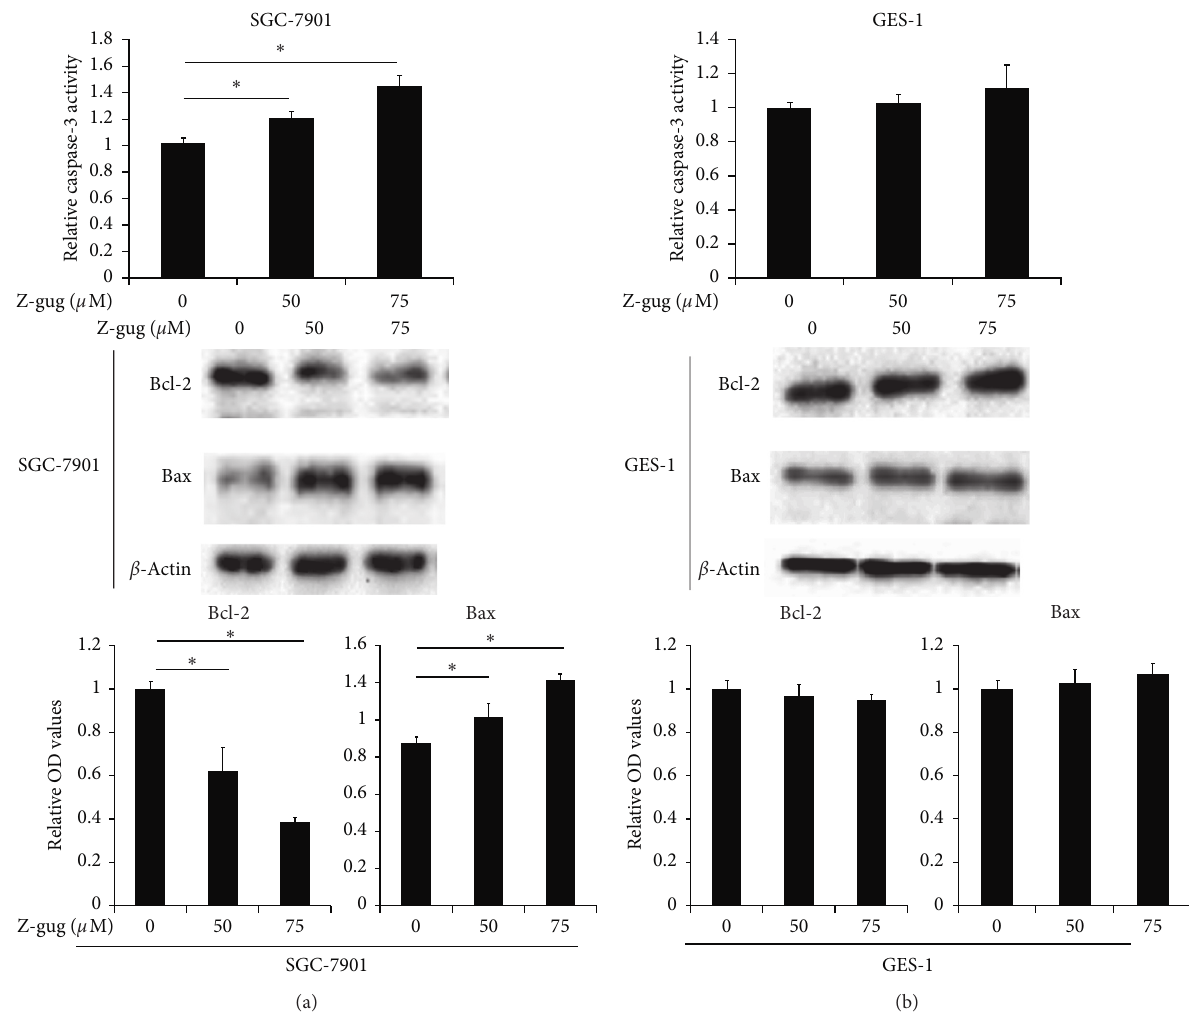
Figure 3: Z-guggulsterone affects the caspase-3 activity and the Bax and Bcl-2 expression in SGC-7901 cells. Cells were incubated with 0, 50, and 75 µ M z-guggulsterone for 24h. (a) Caspase-3 activity level was assessed by ELISA. Data are expressed as means ± SD. ∗ p < 0 . 05 vs. untreated cells. (b) Protein expression of Bcl-2 and Bax was evaluated by western blotting. Quantification of protein bands are shown in the bottom panels. β -Actin was used as a control. Data are expressed as means ± SD. ∗ p < 0 . 05 vs. untreated cells. Z-gug,